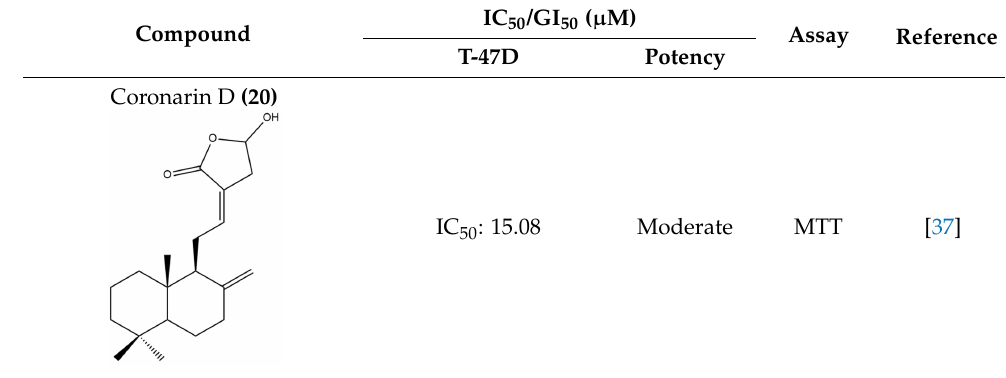
Table 6. Cytotoxic activities of labdane-type diterpenes from the Zingiberaceae against MDA-MB-231 breast cancer cell line.